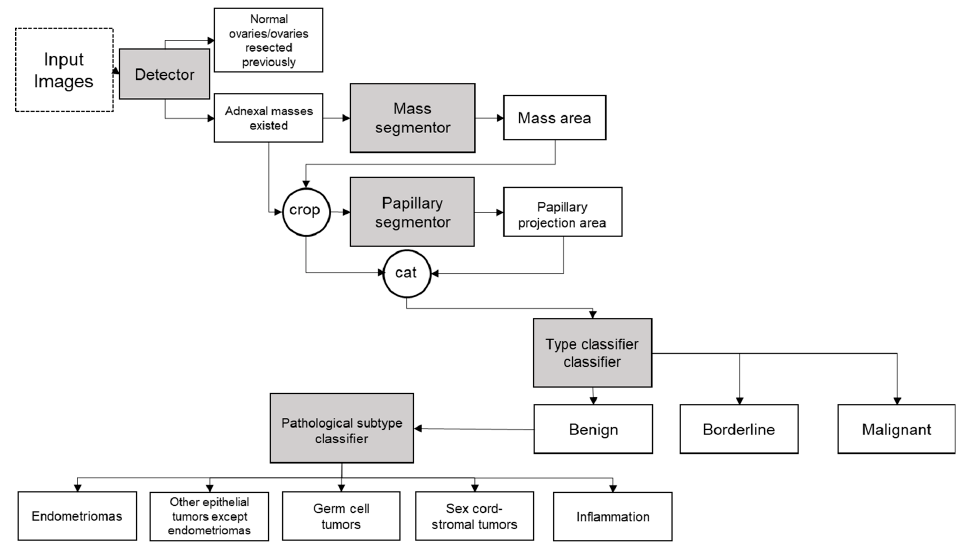
Figure 1. Flowchart of the framework of the DL model system. Images imported into the system are indicated in dotted boxes. Grey boxes show the five parts of the DL model system. Diagnosis results are shown in solid boxes. Images were input into the DL system, and those with adnexal masses were picked out by the detector. The area of masses was recognized by the mass segmentor and papillary projections were located by the papillary segmentor if they existed. The results of these two segmentors and the original images were taken into consideration to make the classification. The type classification would diagnose the adnexal masses into the three types: benign, borderline, and malignant. The borderline and malignant tumors were directly output as the final result. Benign tumors were further distinguished as endometriomas, other epithelial tumors except endometriomas, germ cell tumors, sex cord-stromal tumors, and